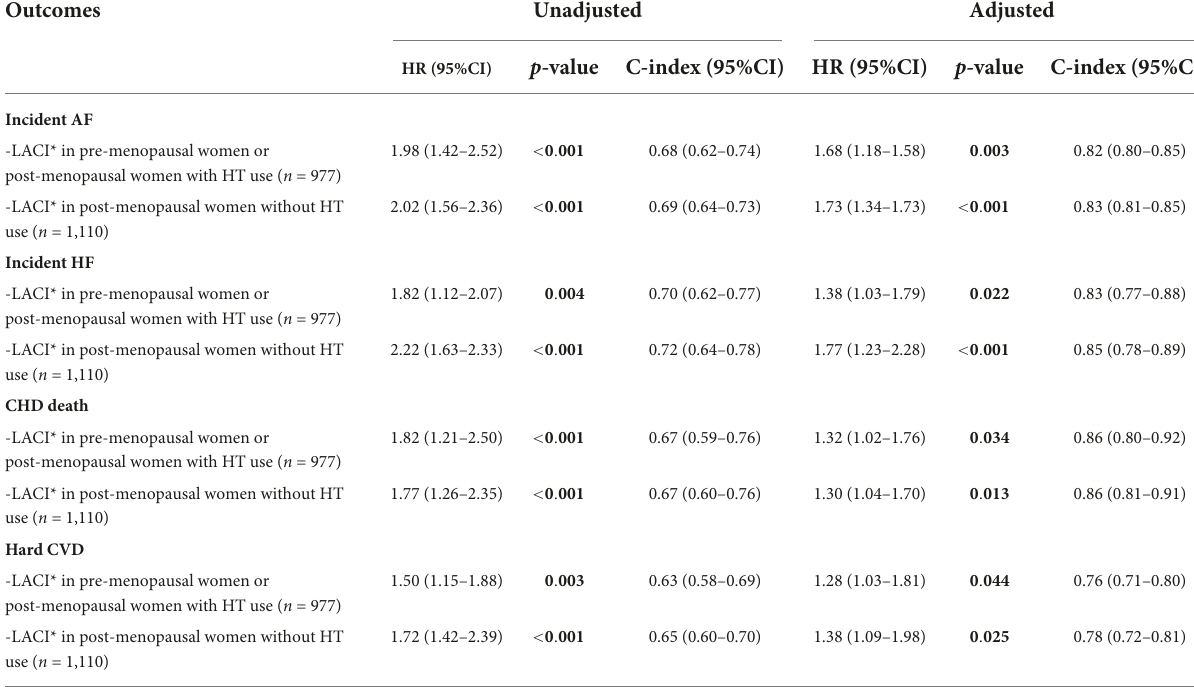
TABLE 3 Univariable and multivariable analysis of left atrioventricular coupling index for prediction of CV events stratified by menopausal status ( n = 2,087). Outcomes Unadjusted Adjusted